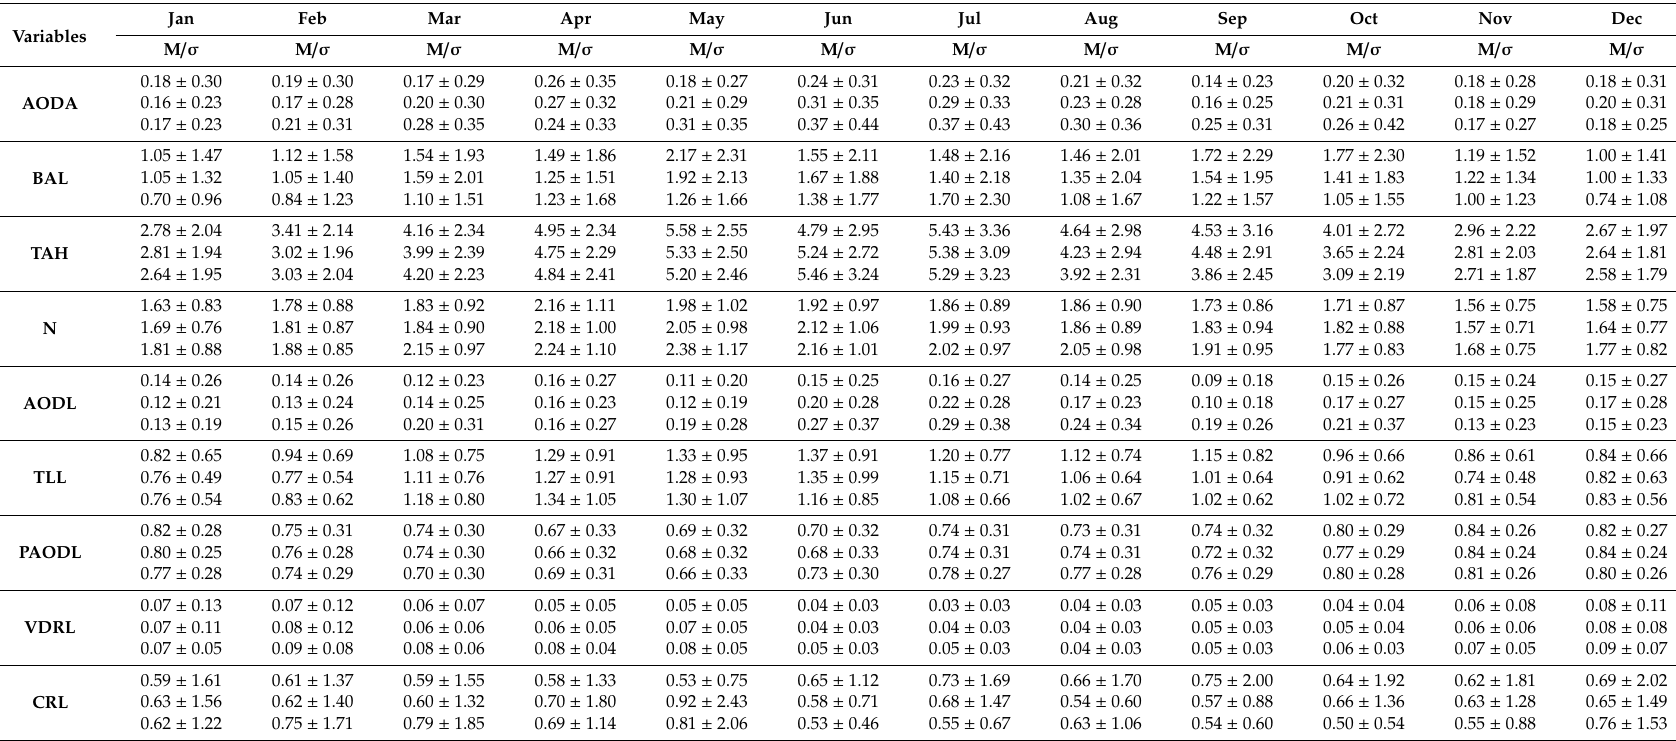
Table 4. Monthly mean and standard deviation values of nine variables in the nighttime over NEC (HLJ, JL, and LN). For each variable, the top row is the value over HLJ, the middle row is the value over JL, and the bottom row is the value over LN.